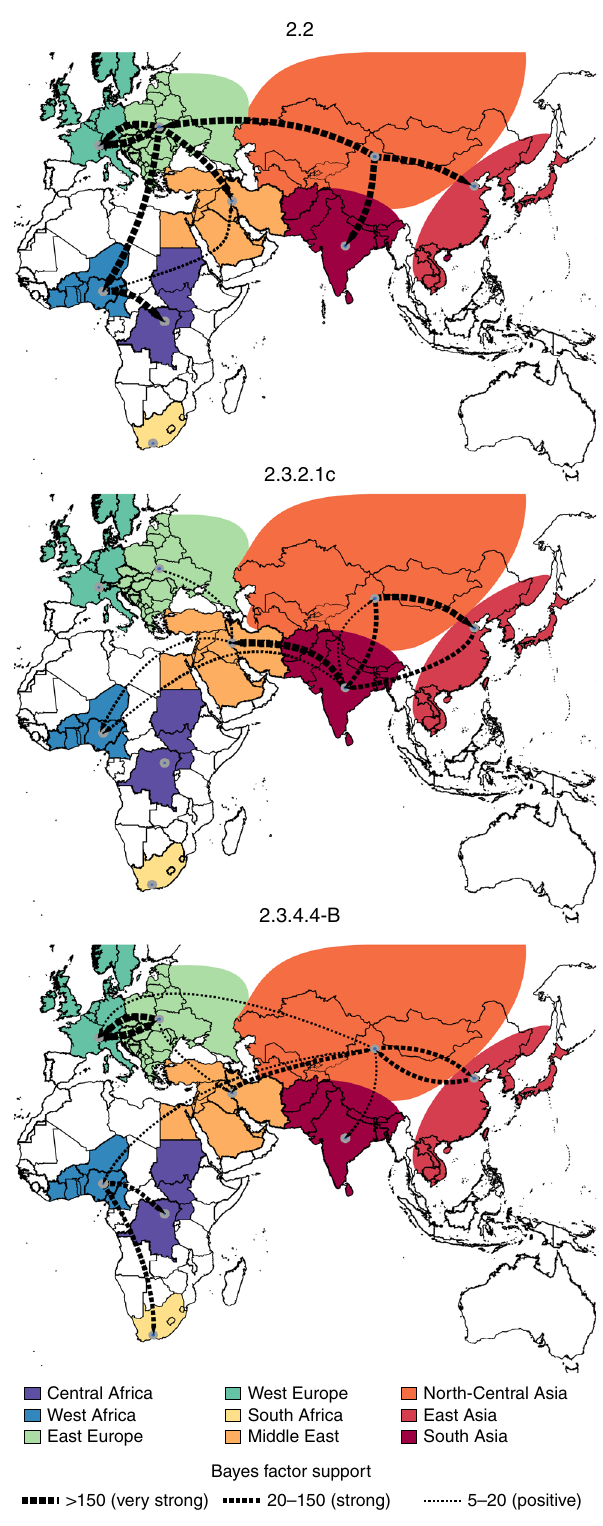
Fig. 1 Global migration rates between geographic regions of the three HPAI H5Nx clades. Maps showing statistically supported non-zero rates (BF>5) for clades 2.2, 2.3.2.1c and 2.3.4.4-B. Areas for each region type are labelled using the same colour in the annotated phylogenetic trees in Supplementary Figs. 3 – 5. The thickness of the dashed lines representing the rates is proportional to the relative strength by which rates are supported for the epi-based datasets shown in the Supplementary Table 1: very strong (BF>150, thick lines), strong (20<BF<150, medium lines) and positive (5<BF<20, thin